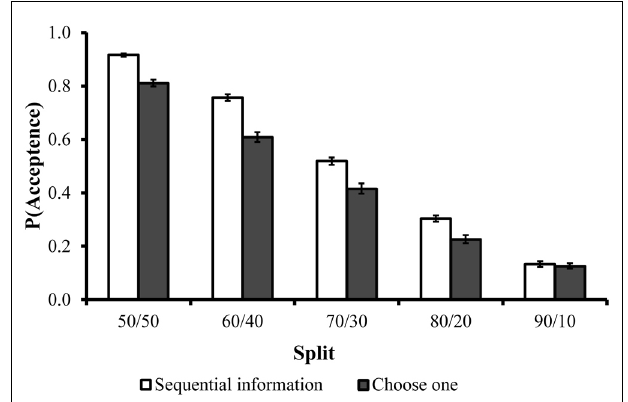
FIGURE 3 | Acceptance rates of each split as a function of experimental condition in Experiment 3. Error bars are depicted in black lines.